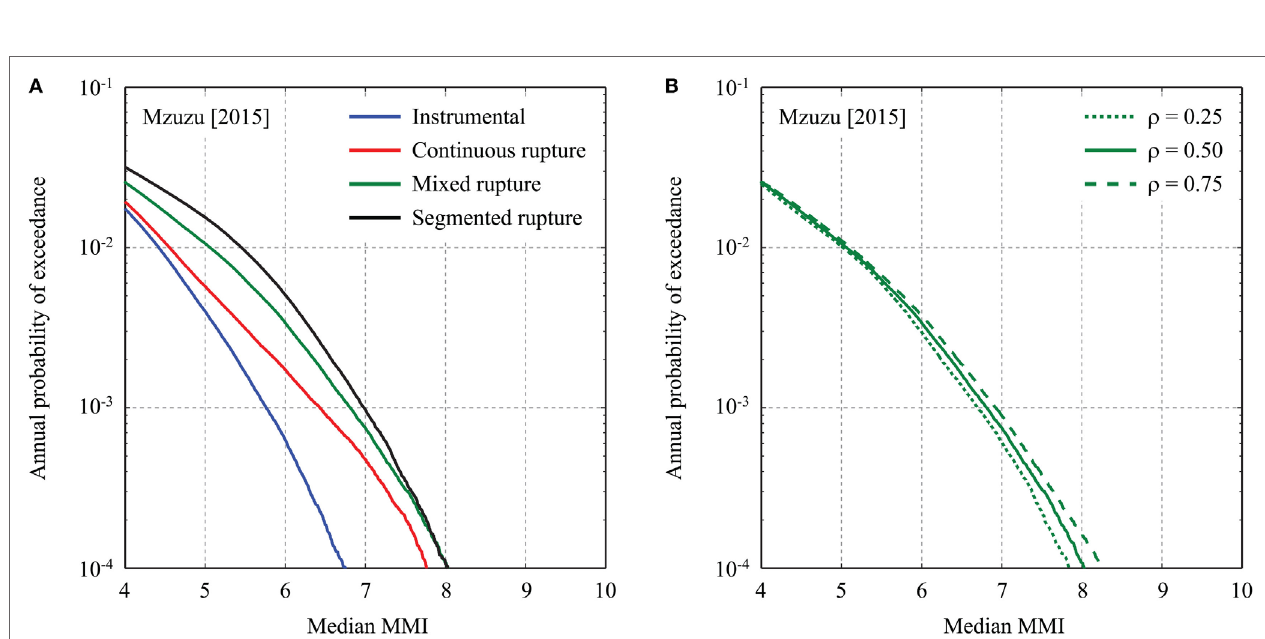
FigUre 9 | (a) Histograms of the number of collapsed buildings for the 2009 Karonga earthquake scenario (USGS model) by considering different vulnerability models. (B) Histograms of the number of collapsed buildings for the 2009 Karonga earthquake scenario (Biggs et al. model) by considering different vulnerability